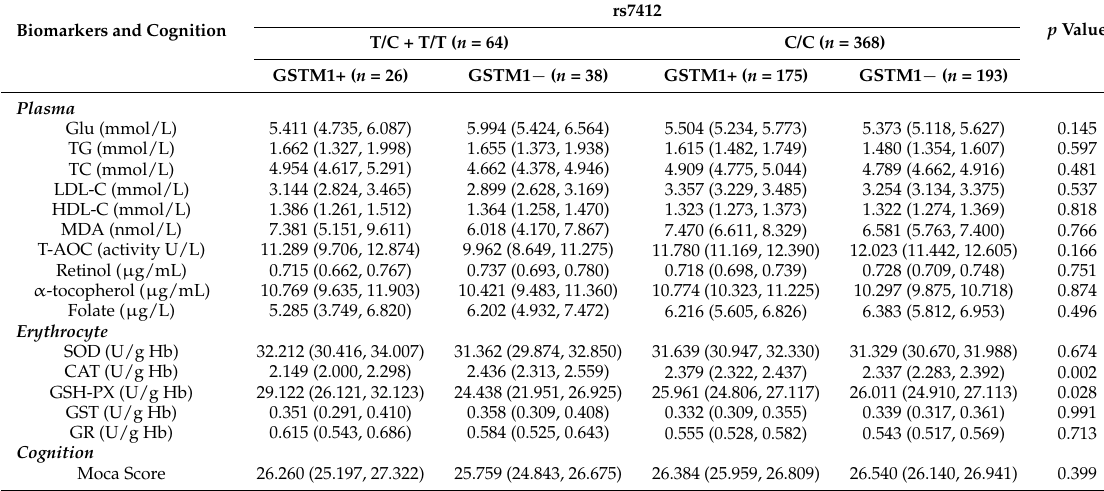
Plasma, erythrocytes parameters and cognition according to APOE rs7412 and GSTM1